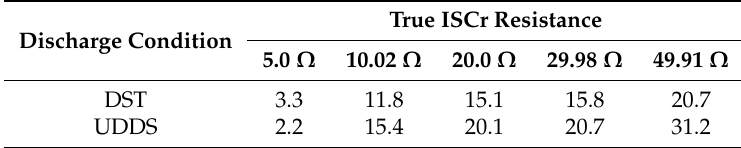
Table 4. Final relative errors (%) of R ISCr in experiment depending on the ISCr